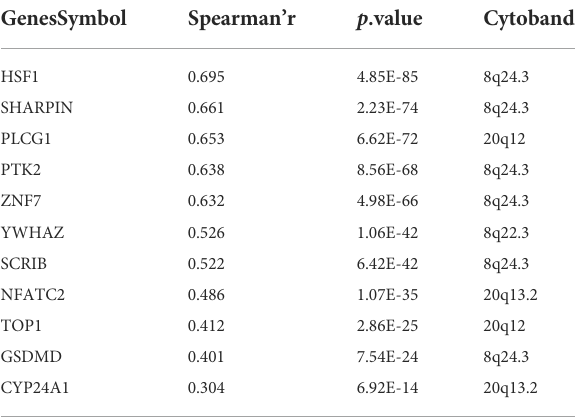
TABLE 3 Eleven in fl ammatory genes with strong correlation.